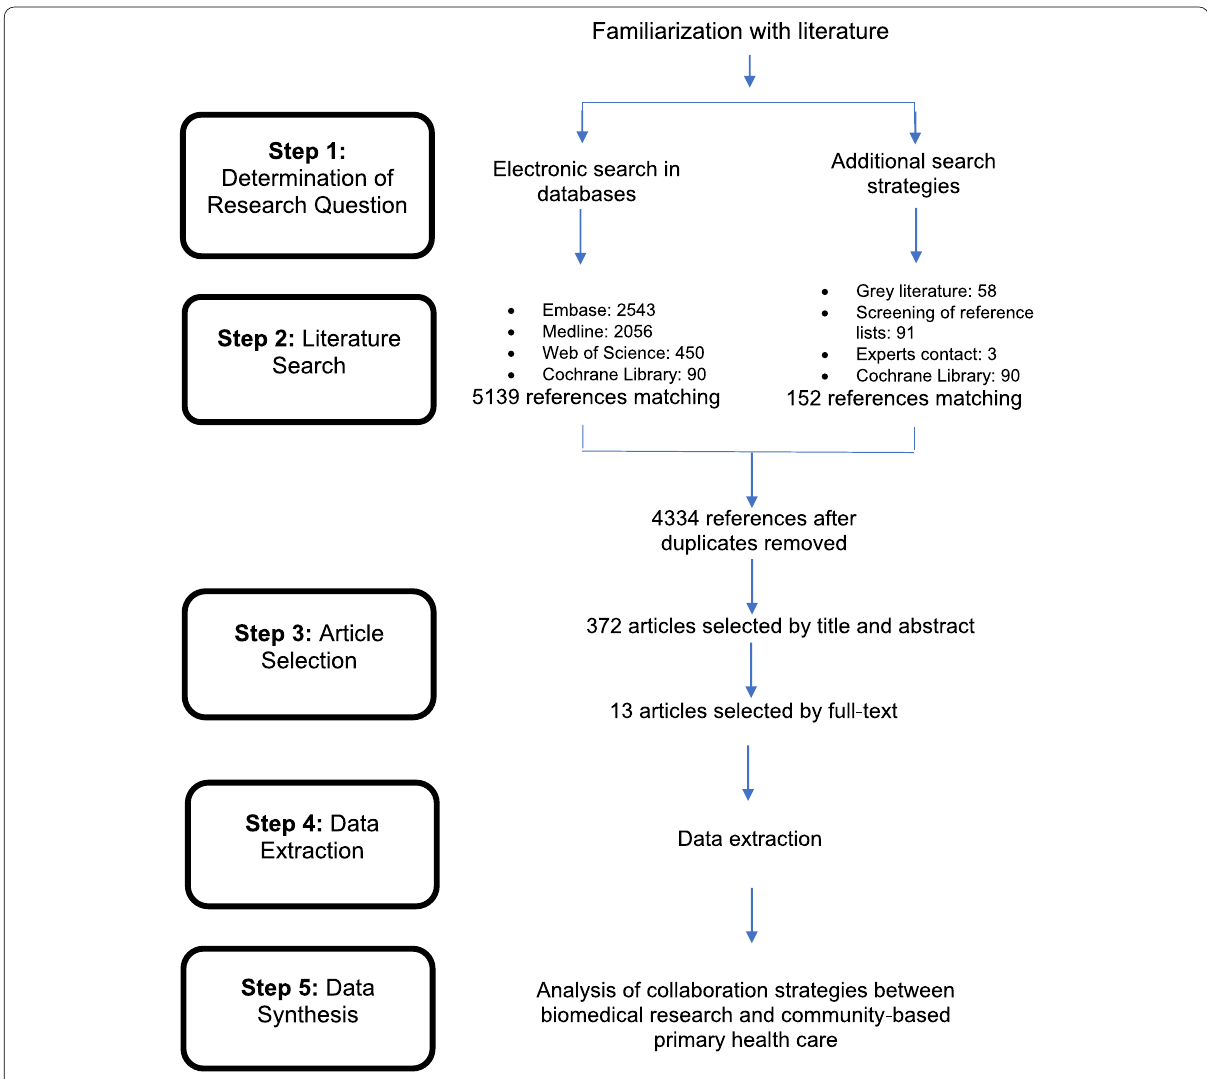
Fig. 1 Flow diagram of literature search for included